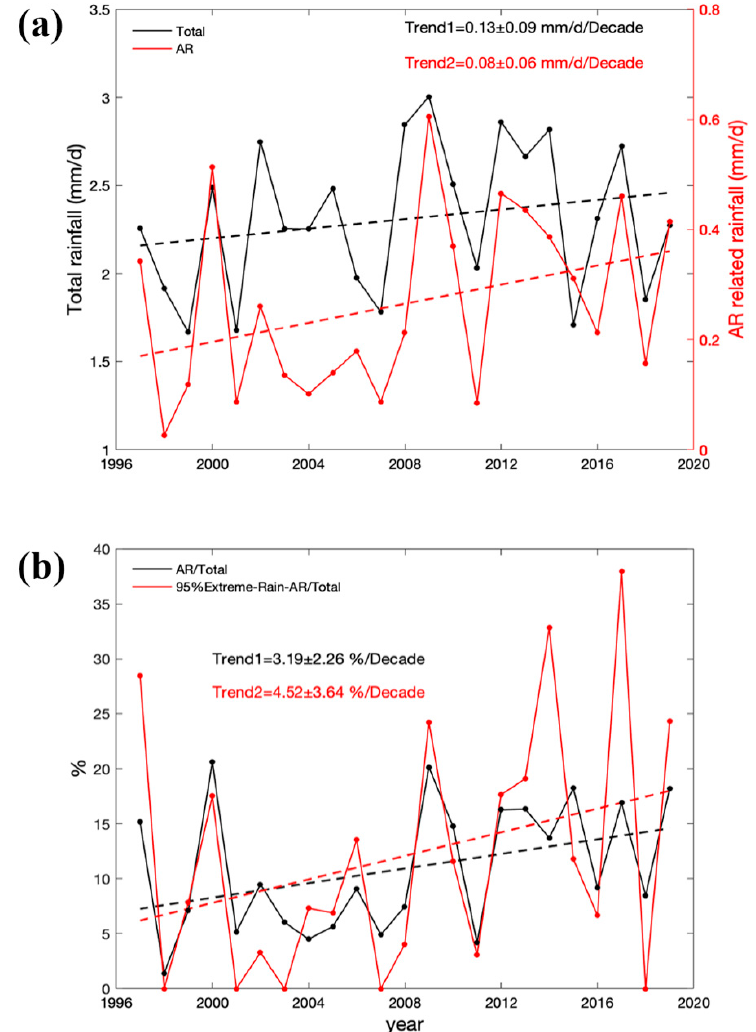
Figure 7. ( a ) Time series of precipitation (solid line) averaged in region (35 ◦ N–44 ◦ N, 10 ◦ W–20 ◦ E) from 1997 to 2019 (mm / d), with linear trend from regression (dashed line). Red is for AR related rainfall and black for total rainfall. The values of the trend ( ± one standard error) are annotated. Trend 2 (red) is significant at the 90% confidence level while Trend 1 (black) did not pass the significance test. ( b ) Red lines: ratio of AR-related rainfall to total rainfall; black lines: ratio of AR-related 95% extreme rain to total 95% extreme rain (%). Trend 2 (red) is significant at the 80% confidence level, while Trend 1 (black) is significant at the 90% confidence level.